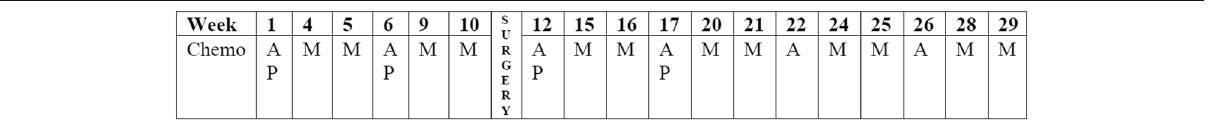
Table 1 Standard protocol for chemotherapy in